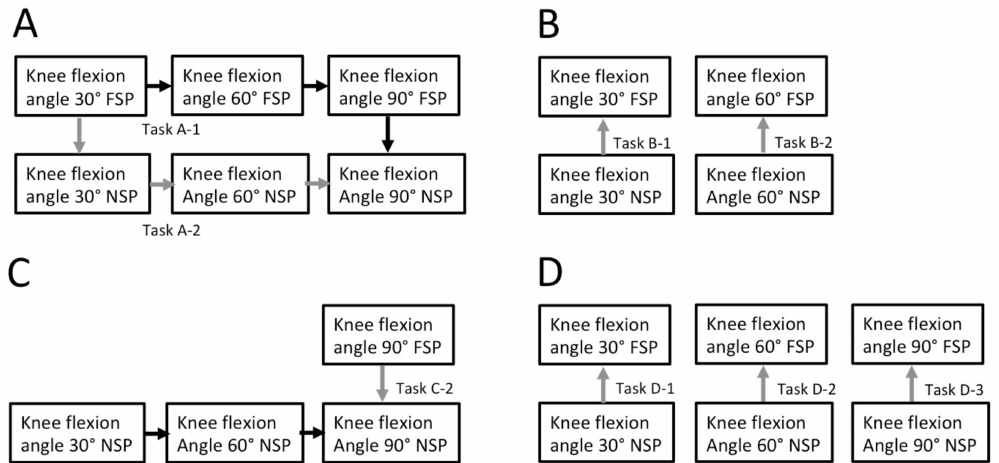
Figure 2. New training tasks. The training tasks are sequential combinations of the isometric squat postures designed to significantly increase the load. Participants hold each posture for 1 min and the muscle activities and the COP are measured accordingly. The targeted muscles are VM ( A ), ST ( B ), TA( C ), and GL ( D